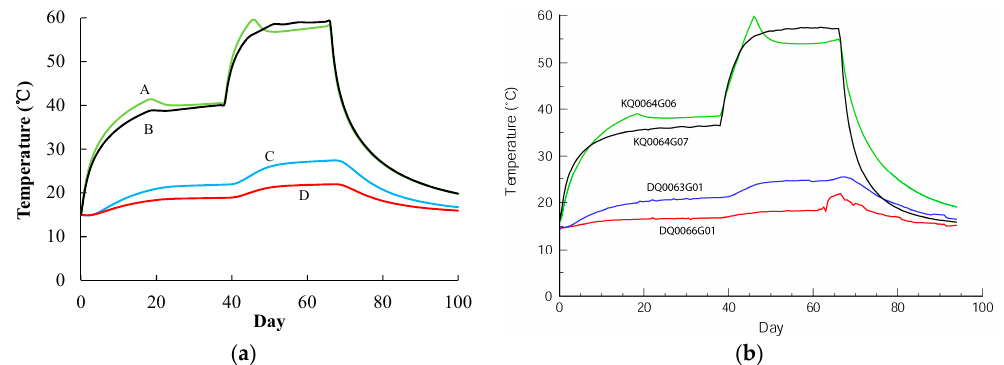
Figure 8. Temperature variation of: ( a ) Simulation result; ( b ) monitoring result [35], courtesy of SKB (From SKB TR-07-01 (Andersson 2007)).